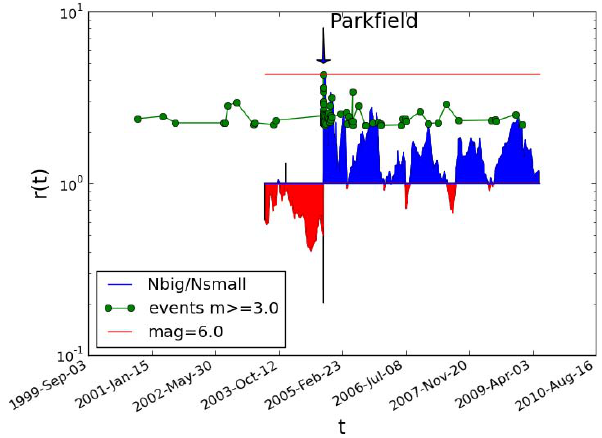
Fig. 8. The ratios of record-breaking longest intervals to record- i breaking shorter intervals, r(t) , in the Parkfield aftershock sequence rb - min (illustrated in Fig. 3) with minimum magnitude m c > 1 . 5 are shown as a function of date. Large and small record breaking intervals are counted forward starting from the 256-th interval preceding the in- terval ending at the time t . Each value, r(n = 256 ,t i ) is smoothed by averaging over the preceding 16values. Blue regions, where r(n,t) > 1, imply aftershocks, or at least some form of decreasing mean seismicity; red regions, where r(n,t)< 1, suggest an increas- ing rate of